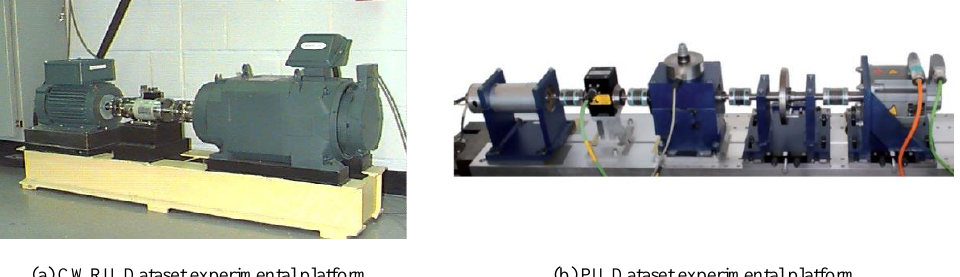
Figure 4. Experimental platforms for CWRU dataset [38] and PU dataset [39]. Reprinted with permission from Ref. [38]. Copyright 2015